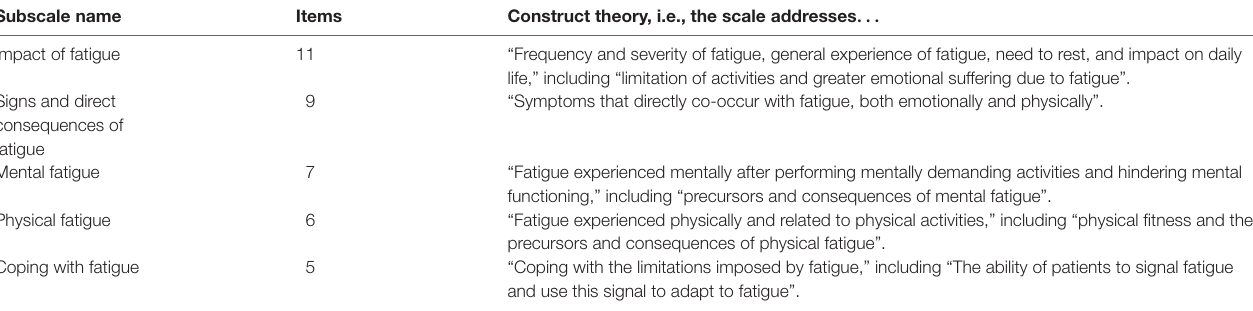
TABLE 1 | Construct theory of subscales on the Dutch Multifactor Fatigue Scale. Subscale name